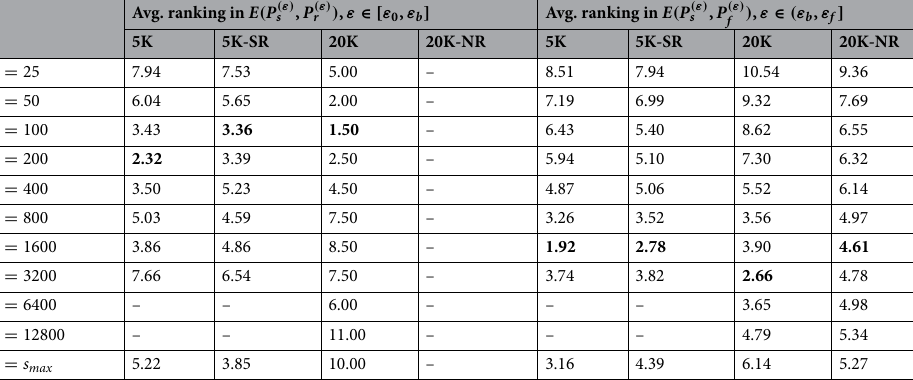
Table 1. Effectiveness of s -LID in detecting microbands and shearbands. At each strain stage, the effectiveness of all neighborhood sizes are quantified and ranked, then the average ranking of them over stages in the corresponding regime are reported. For each sample, the lowest ranking value (the lower the value, the higher the effectiveness) is highlighted in bold, which gives the optimal neighborhood size for detecting the corresponding strain localization pattern ( s ∗ l for microbands and s ∗ h for shearbands). Note s max = 5097 (ε) for samples 5K and 5K-SR, and no rotation pattern P r can be used for sample 20K-NR since rotation is completely